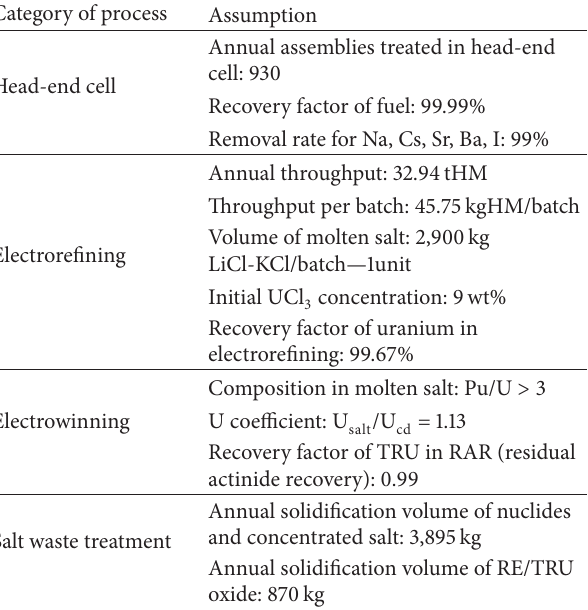
Table 3: Main constraints of prime